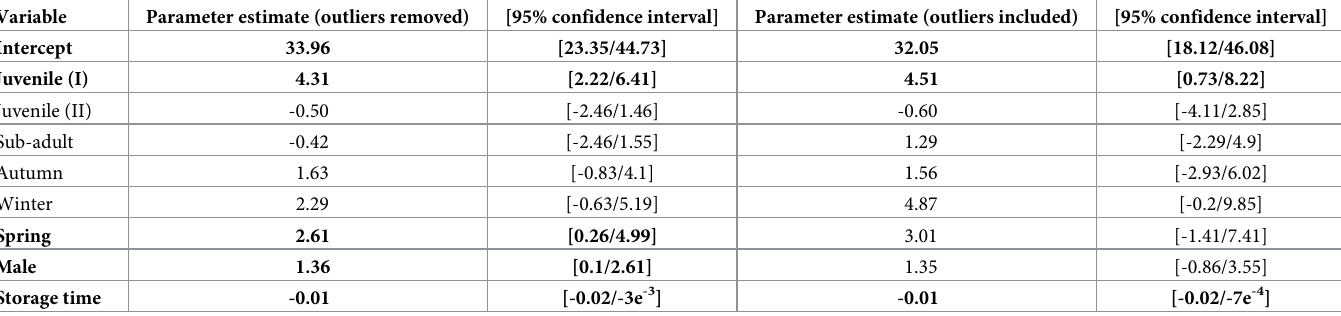
Table 2. Effects of age, sex, season and storage time on hair cortisol concentration of Egyptian mongoose in two models fitted with and without two major outliers.